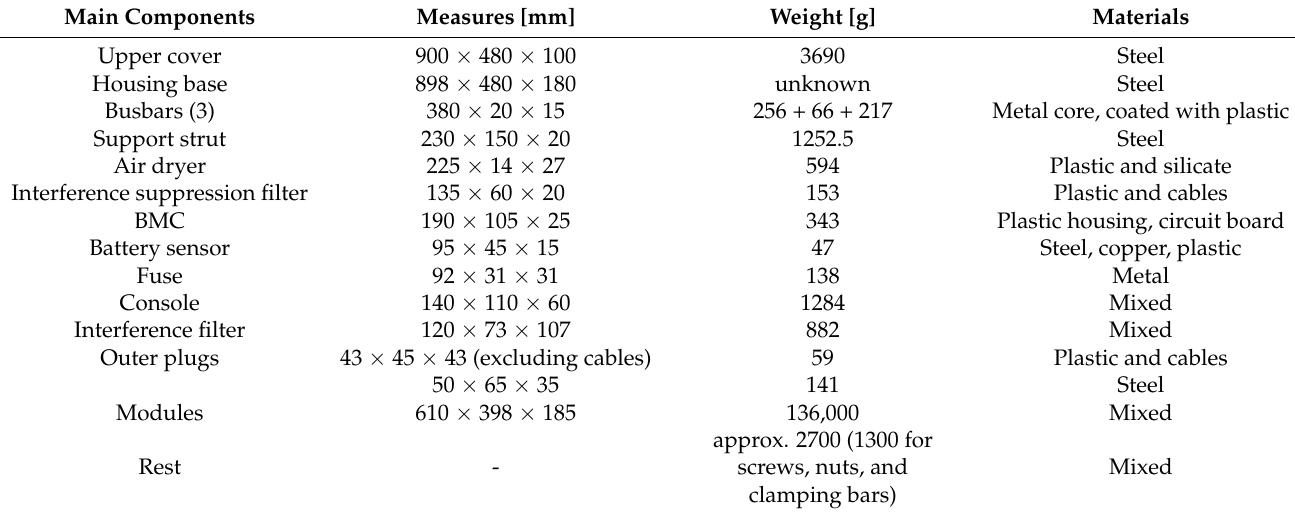
Table 4. Retrieved components and some of their corresponding